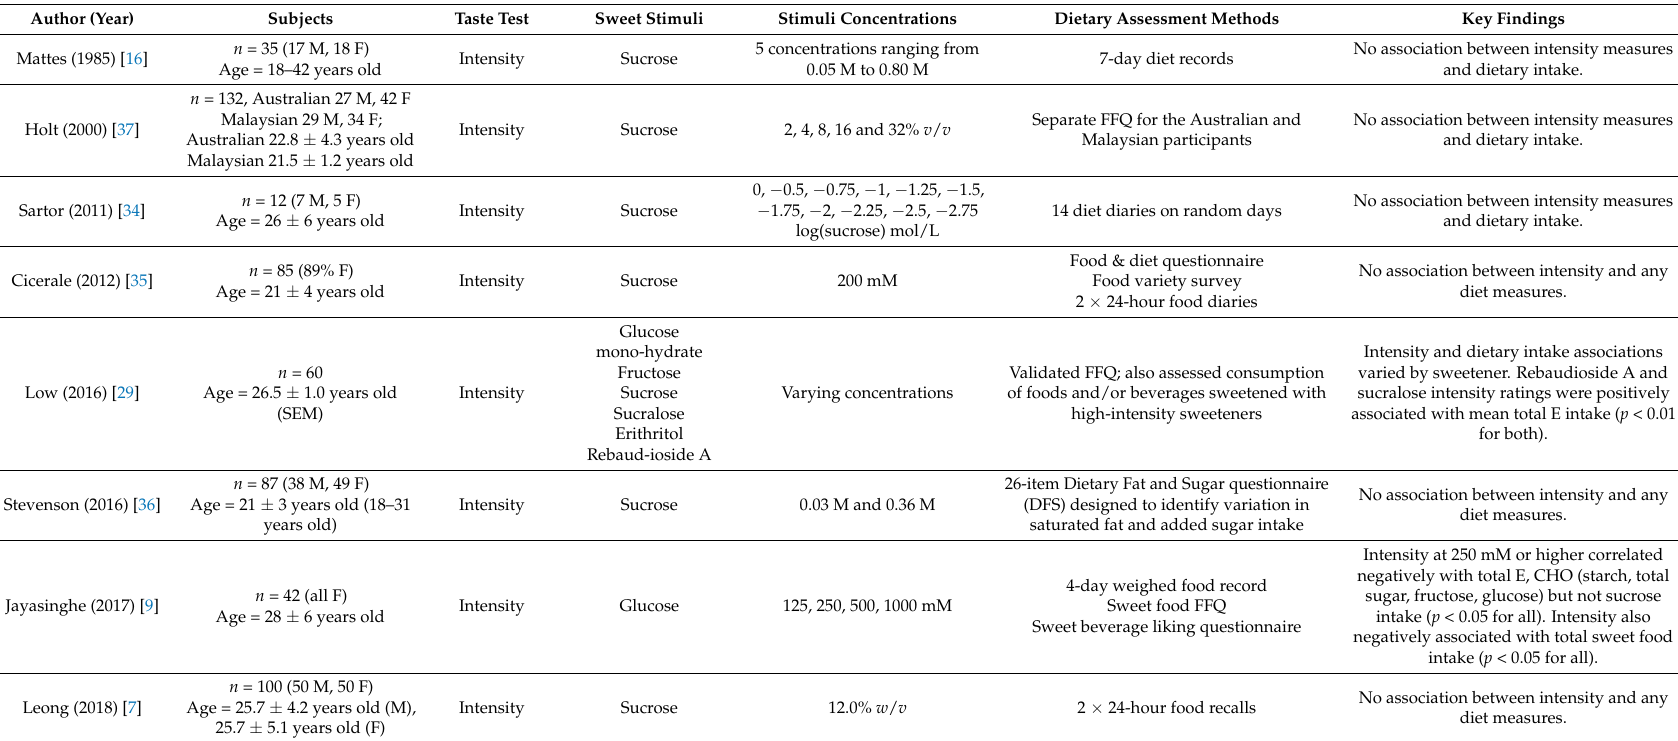
Table 2. Intensity Studies Examining Taste-Diet